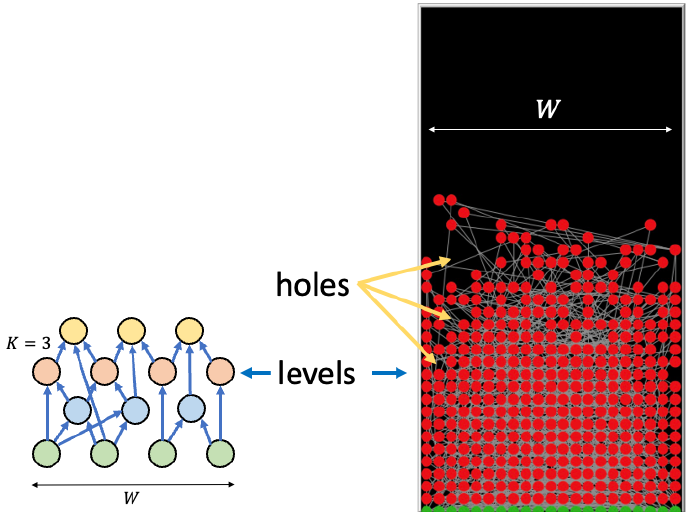
Figure 1. The fundamental knowledge scaffolding model. ( left ) Knowledge bits are represented as nodes of a network, where different colors represent different levels and nodes at a certain level only depend on a certain number of nodes at lower levels. Green (basic) nodes represent axioms. ( right ) Observing the filling of the network (here with fixed width W and with fixed number of dependencies K ), one can detect holes that are filled after the appearance of nodes at higher